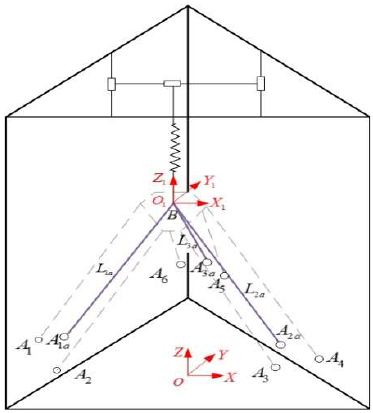
Figure 4. Equivalent schematic diagram of the CDPR for 3D Printing.